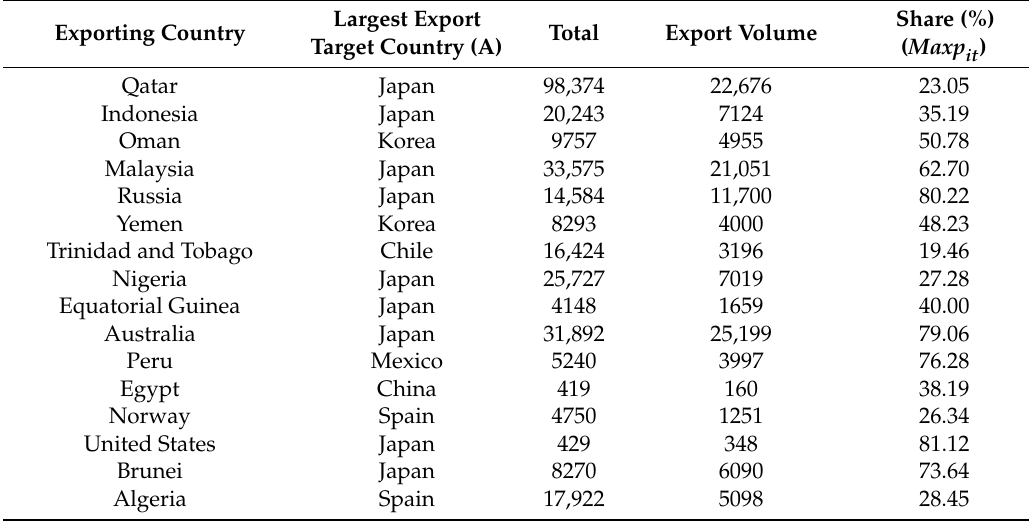
Table 1. Liquefied natural gas (LNG) export amounts of exporting countries